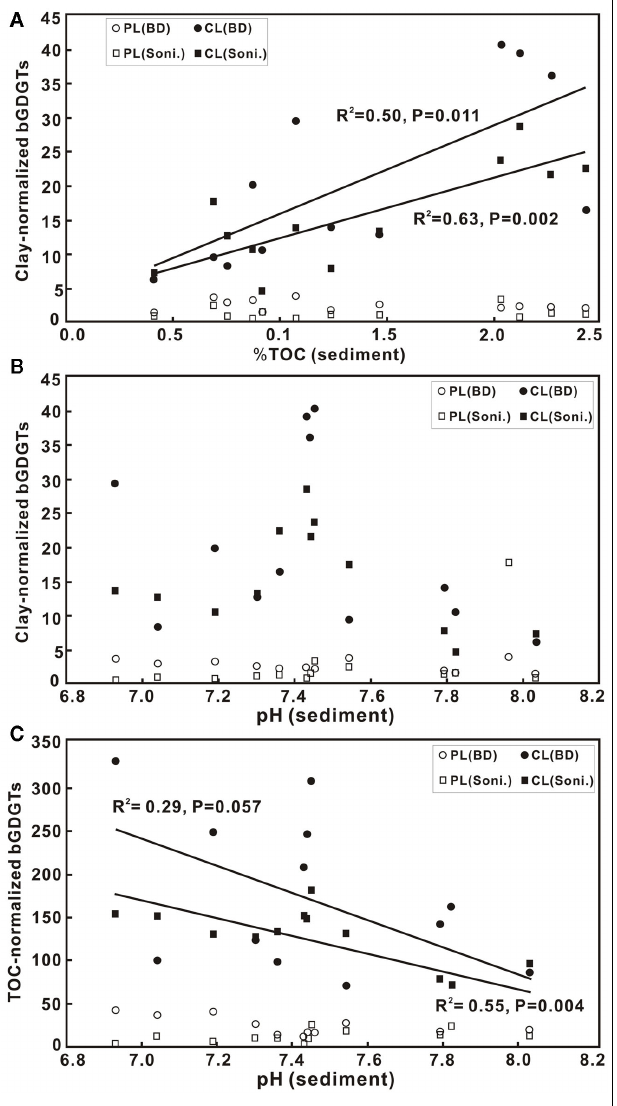
FIGURE 4 | Scatter diagrams ofTOC in sediments vs. clay-normalized bGDGTs in ng/g × 10 2 (A), and pH vs. clay-normalized bGDGTs in ng/g × 10 2 (B) andTOC-normalized bGDGTs in ng/g × 10 2 (C) for both sonication (Soni) and Bligh and Dyer (BD) methods. CL, core lipids; PL, polar